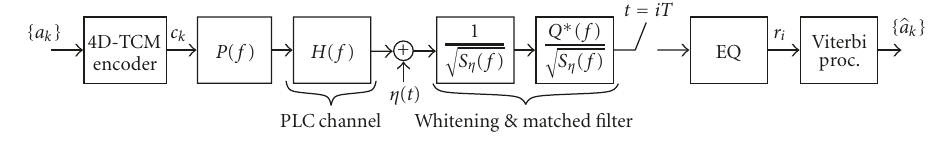
Figure 1: Simplified system model with optimum receiver for colored